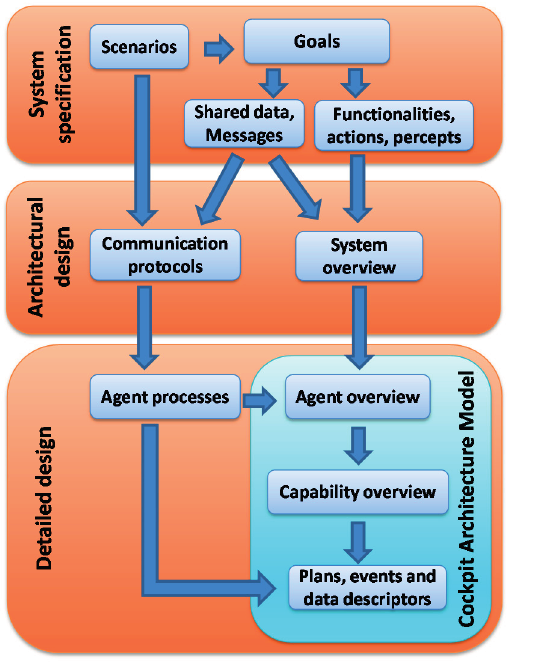
Figure 1. Methodological